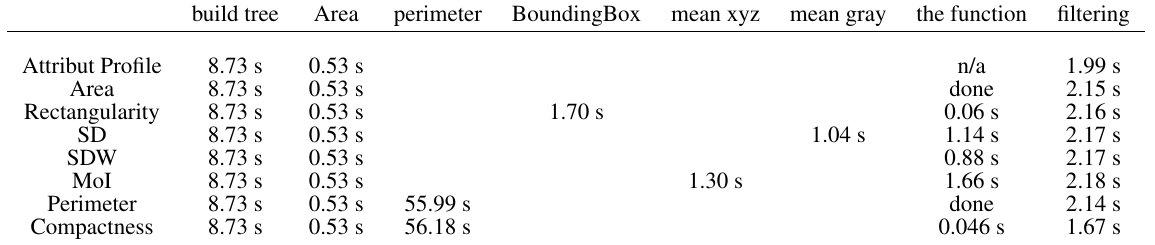
Table 1. Computation time according to the feature profiles with remote sensing image in Figure 8 (run on AMD Ryzen Threadripper 1950X 16-Core Processor, 64GB ram). build tree